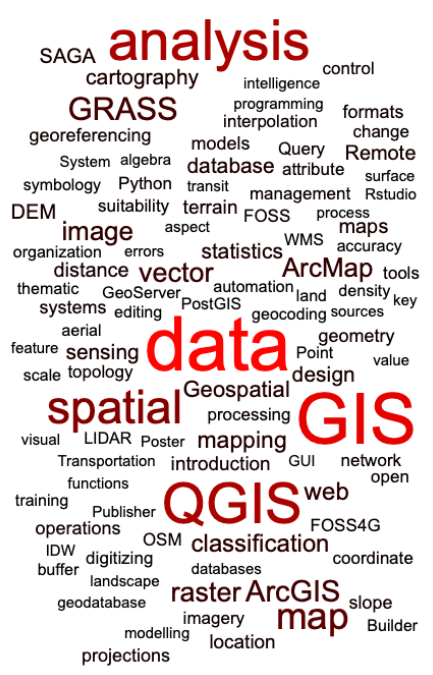
Figure 1. Keywords used to describe the geospatial educational